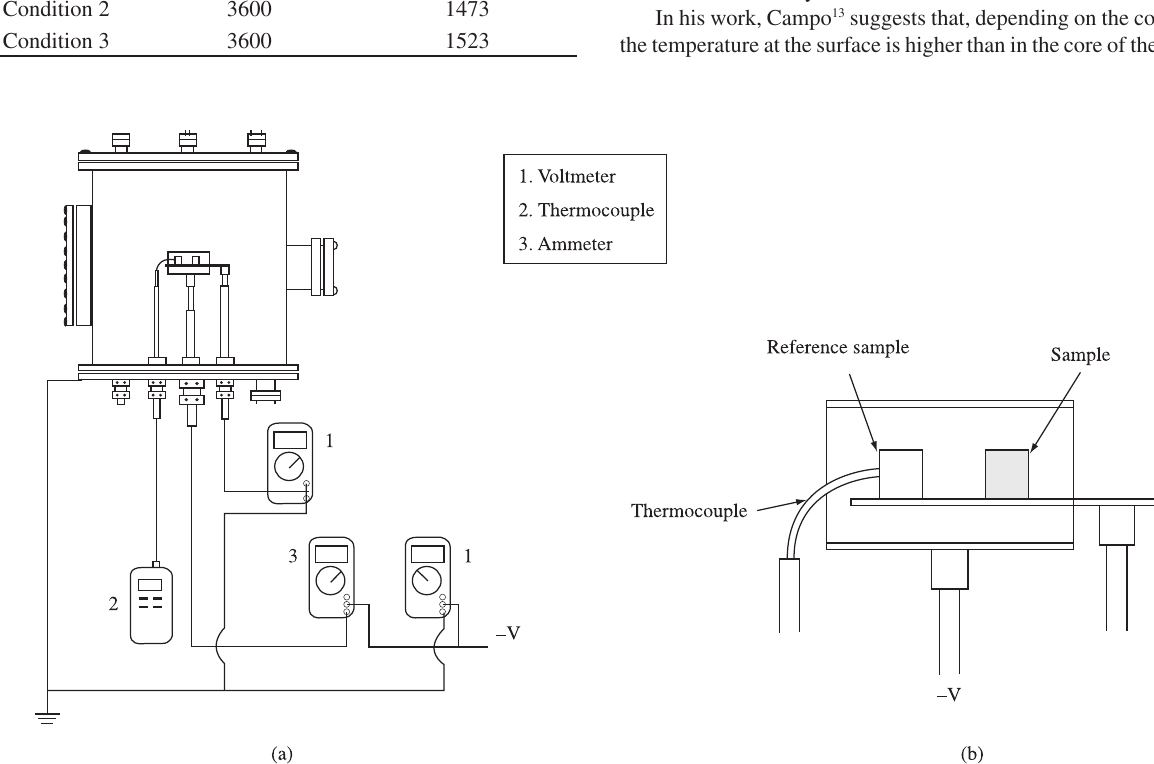
Figure 4. (a) Schematic representation of the configuration CAN and (b) detail of the position of the sintered sample and the reference